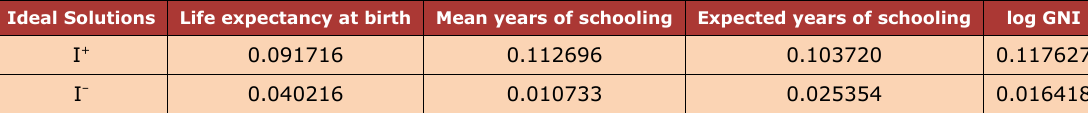
Table 4. PIS and NIS